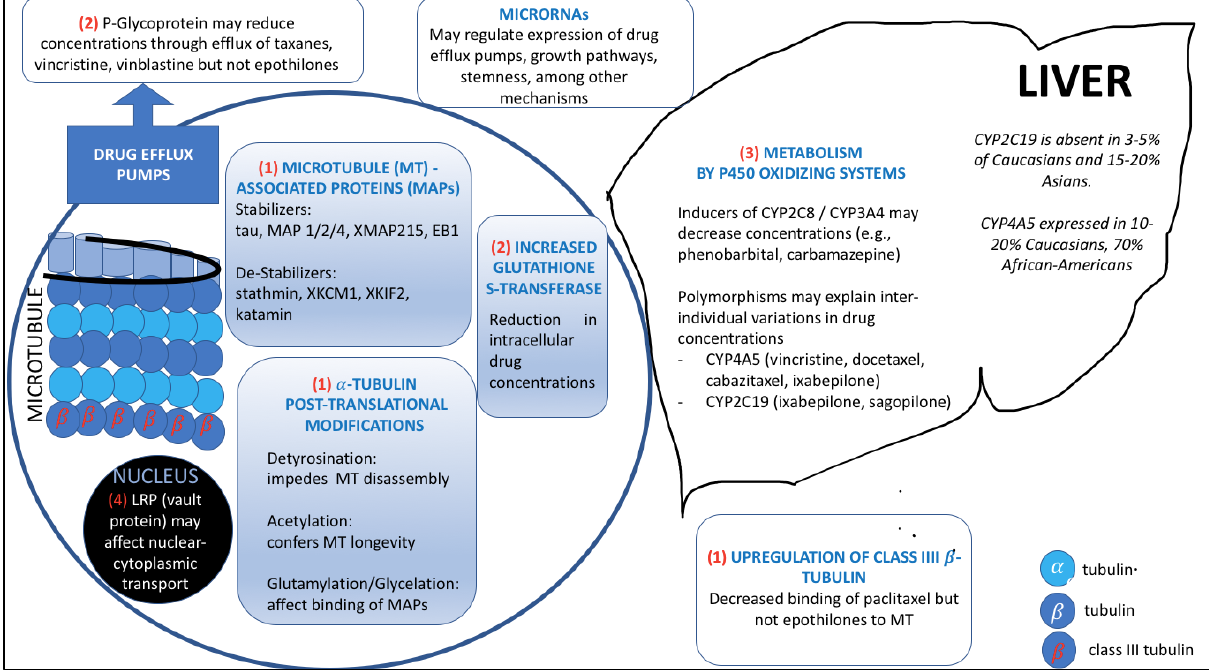
Figure 1. Mechanisms of drug resistance include alteration of the drug target (1), reduction of concentrations due to enhanced export from the cell (2) or enhanced metabolism (3), altered nuclear-cytoplasmic shuttling (4), and increased ability to counter drug-induced damage or apoptosis through altered expression of Bax, Bcl-2, AKT, surviving, sorcin, MDA, SKP2, F-Box proteins, Gli proteins, and sphingolipids, among many others.